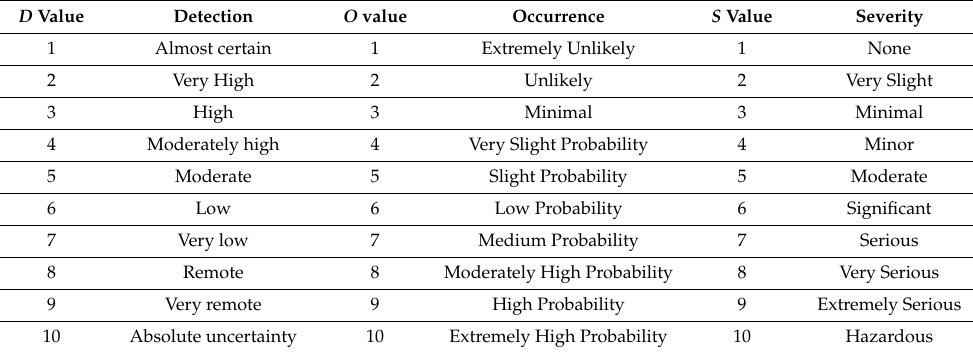
Table 1. D , O, and S evaluation criteria.